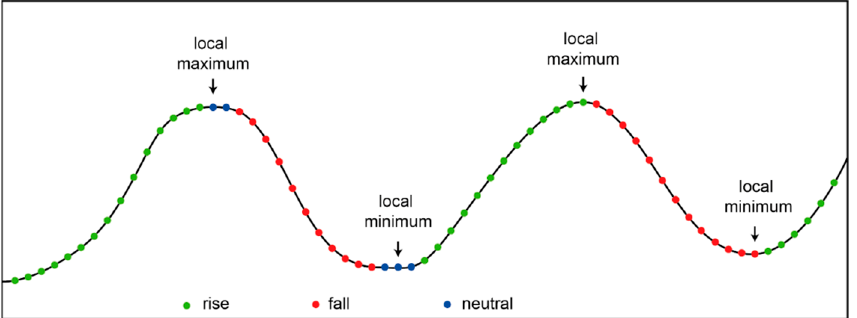
Figure 3. Illustration of the method to identify turning points. Each pixel is compared with the value of the preceding pixel and is categorised as a rise, fall or neutral point. Local maxima and minima correspond to the mid points between a rise and a fall and a fall and a rise, respectively.